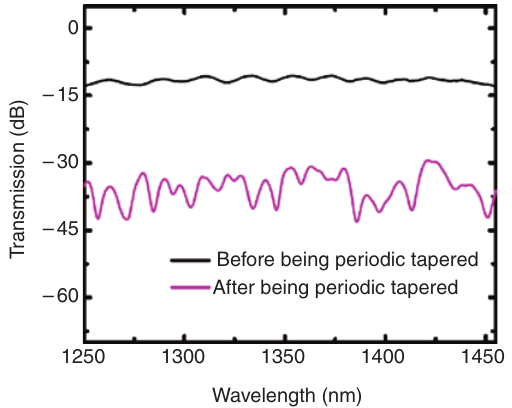
Figure 2: Transmission spectra of the all-solid WAF before and after being periodically